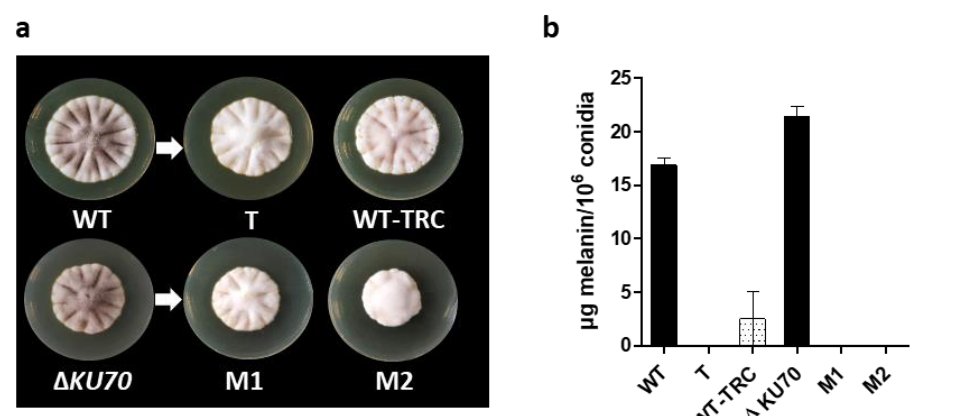
Figure 3. Detection of melanin in parental and mutant S. apiospermum strains. ( a ) Macroscopic aspect of parental and mutant strains after nine days at 37 °C on PDA medium. WT-TRC indicates the WT strain grown on a PDA plate supplemented with 50 µg/mL tricyclazole as a specific inhibitor of melanin biosynthesis. ( b ) Melanin quantity per million conidia, extrapolated from a standard curve of synthetic melanin, determined by EPR (Graph representative of at least three independent measurements). T: transformant derived from the WT strain; M1 and M2: transformants derived from the ∆ KU70 strain.